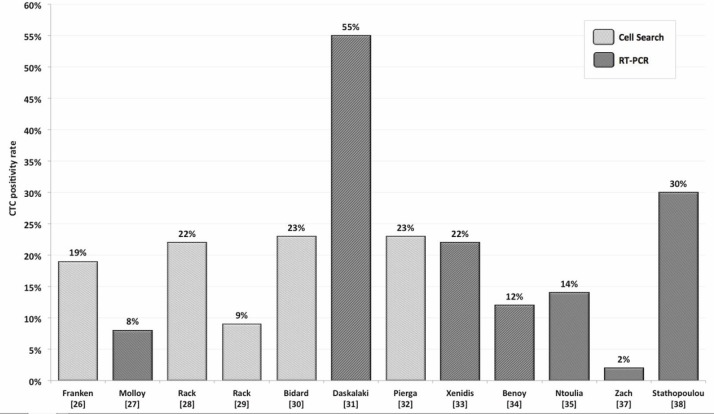
CTC positivity rates depending on detection method reported by several authors.